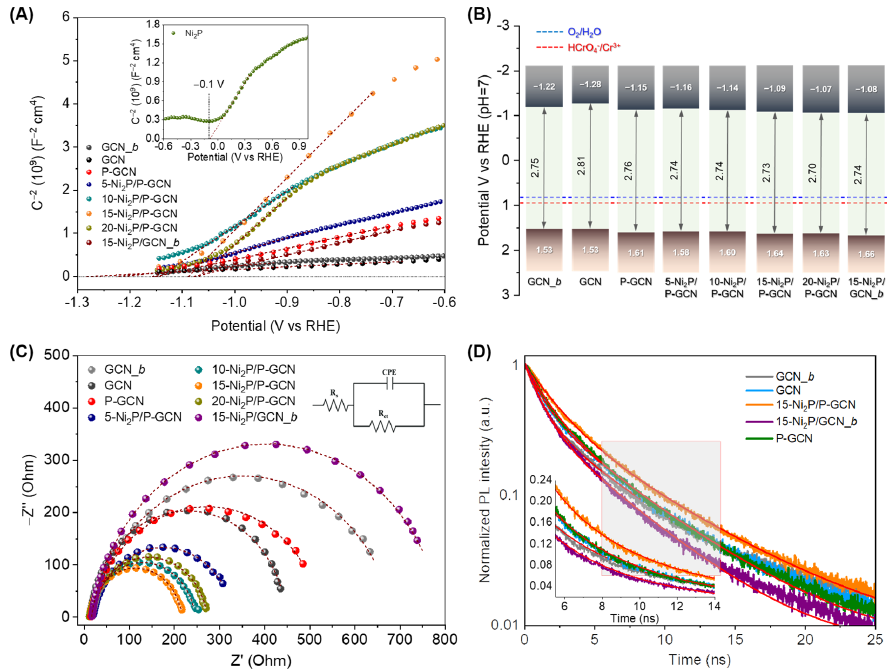
Figure 5. ( A ) Mott–Schottky plots (Inset: the Mott–Schottky plot of the as-prepared Ni 2 P microparticles), ( B ) band-edge potentials and ( C ) Nyquist diagrams (Inset: Randles equivalent circuit model